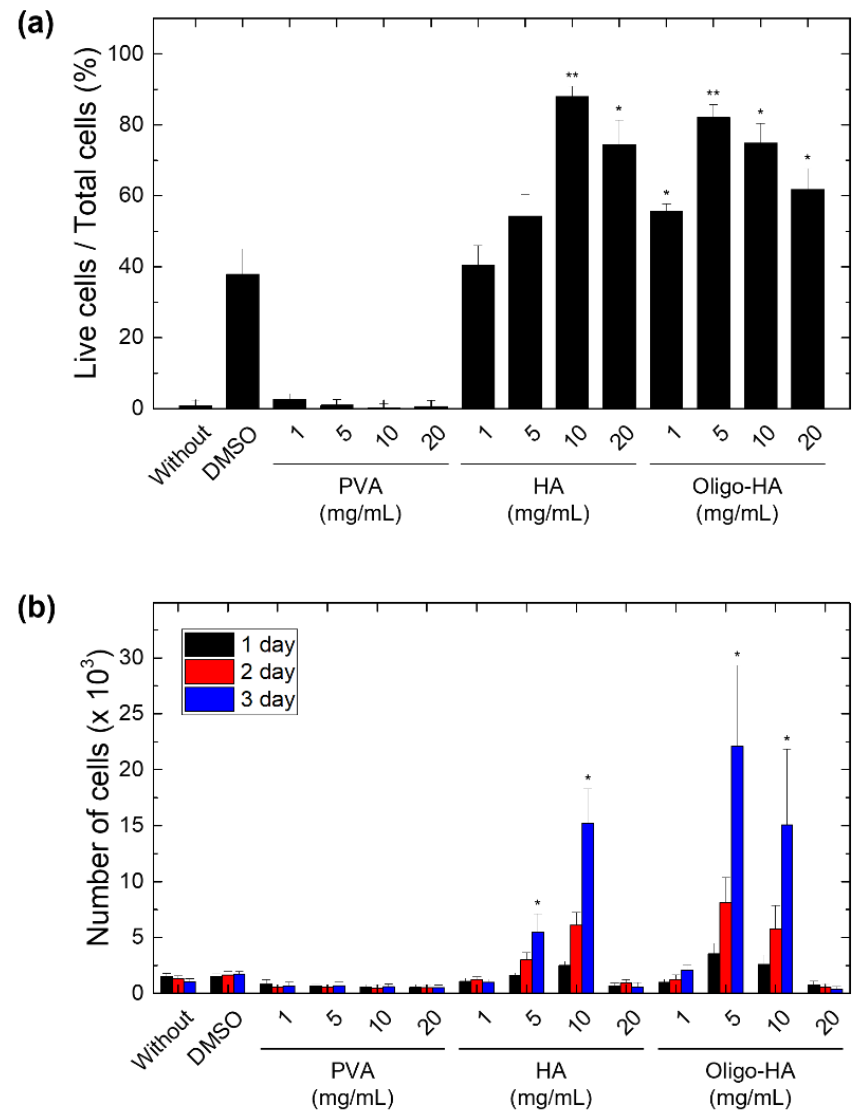
Figure 1. Effect of polymeric supplements on cell cryopreservation. ( a ) The bar graph shows the ratio of living cells per total cells. Polyvinyl alcohol (PVA) and hyaluronic acids (HA) with different concentrations were supplemented to dimethyl sulfoxide (DMSO) cryopreservation media. Dulbecco’s modified Eagle’s medium (DMEM) media without DMSO (without group) was used as a control. ( b ) The graph shows cell proliferation for 3 d after cell thawing. The data represent the mean ± S.D. * p < 0.05 and ** p < 0.01 vs. DMSO. (n = 5)